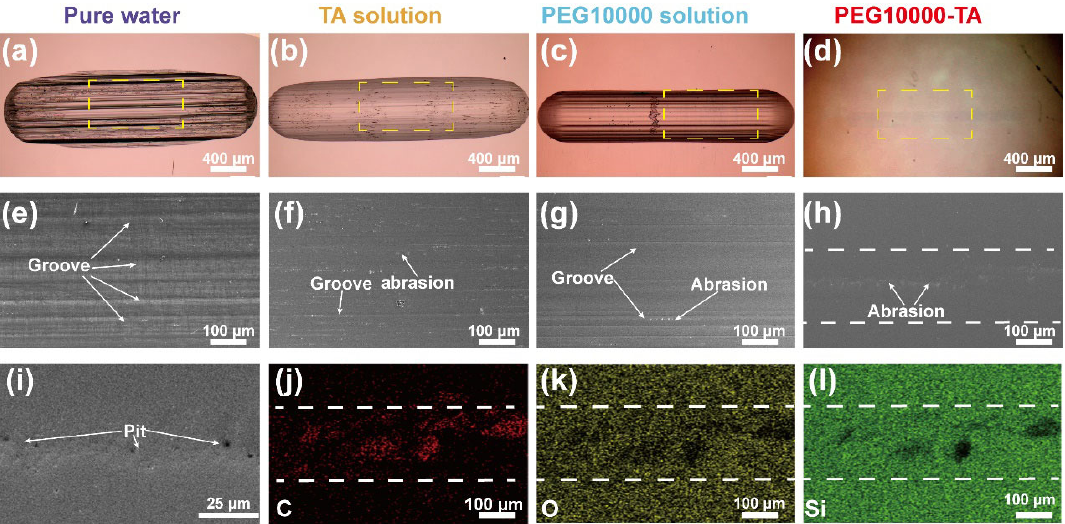
Fig. 7 Optical and SEM images of the wear regions on the glass sheet lubricated with (a, e) pure water, (b, f) TA solution, (c, g) PEG10000 solution, and (d, h, i) PEG10000-TA. (a–d) Overall perspectives and (e–i) detailed images of the wear scar. EDS mapping analysis for (j) C, (k) O, and (l) Si of (i) abrasion after the friction test when PEG10000-TA was used as the lubricant. The load applied was 4 N, the maximum linear velocity was 0.025 m/s, and the friction test time is 20 min. The mass fractions of PEG10000 and TA in the lubricant used were 45 wt% and 2 wt%,